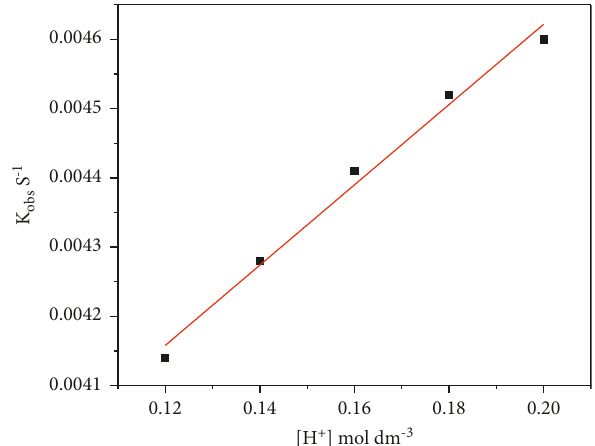
Figure 3: k + ] at the following conditions: [Ce (IV)] � obs versus [H 6.0 × 10 − 4 moldm − 3 and [Maltose] � 6.0 × 10 − 3 mol dm − 3 at